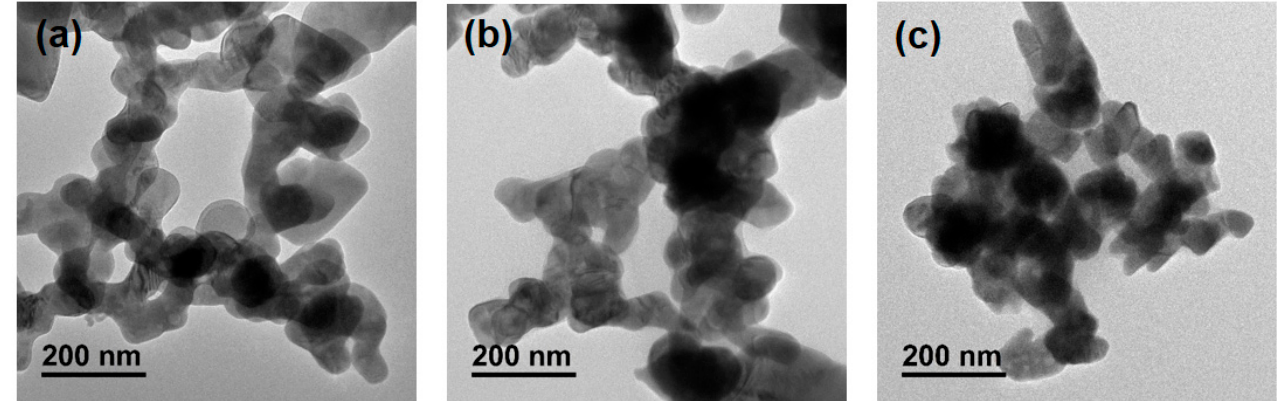
Figure 2. TEM micrographs of hydrothermally synthesized BiVO 4 -based nanoparticles. ( a ) undoped, ( b ) W-doped, and ( c ) Mo-doped BiVO 4 samples.